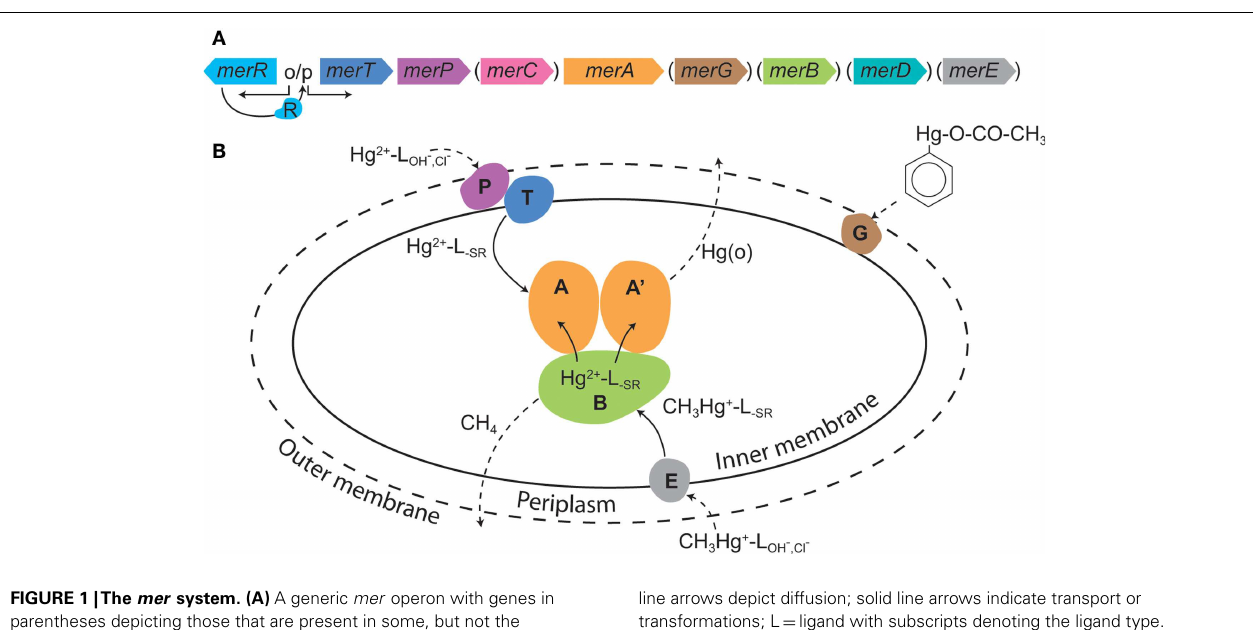
FIGURE 1 |The mer system. (A) A generic mer operon with genes in parentheses depicting those that are present in some, but not the majority of, operons. (B) The cellular mer -encoded mercury detoxification mechanisms.The outer cell wall is depicted by a broken line illustrating that not all microbes have an outer membrane; broken